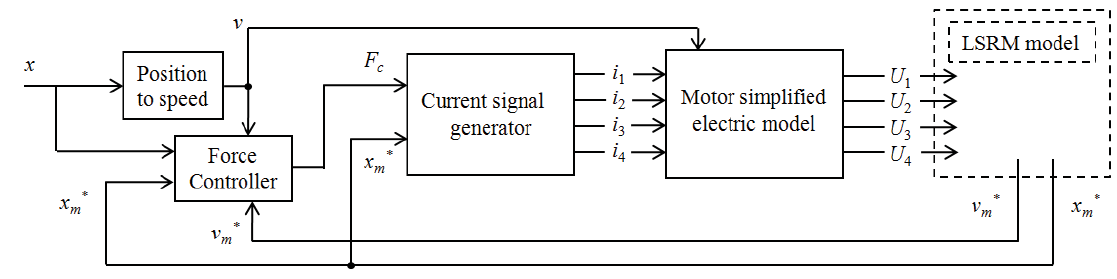
Figure 14. Closed loop control of the